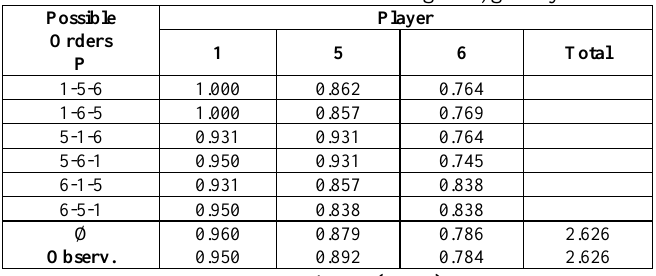
Table 8: Possible orders for 12-brood game, good years.